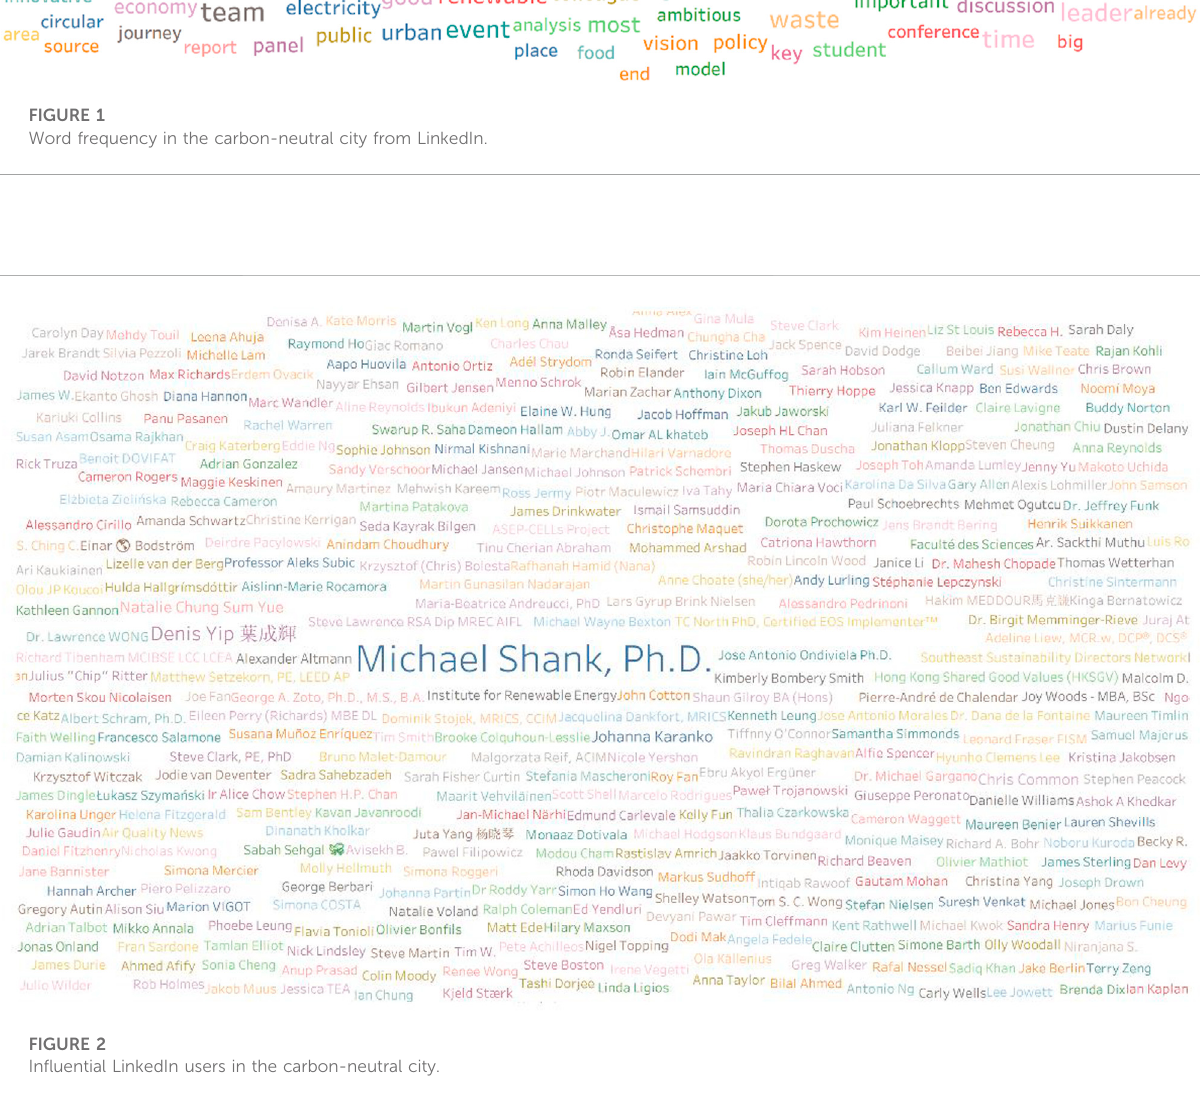
In fl uential LinkedIn users in the carbon-neutral